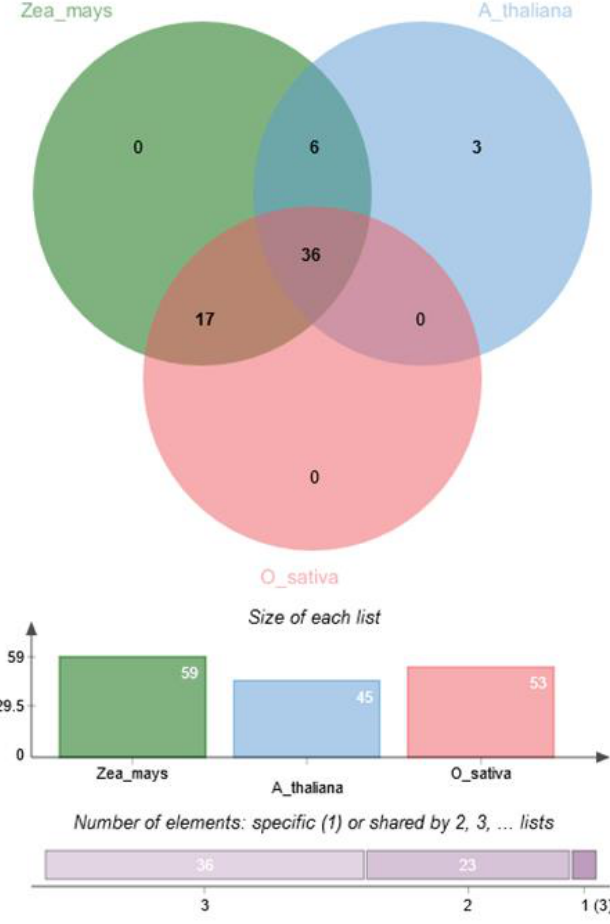
Figure 6. Venn diagram showing the co-expression clusters and overlaps between maize (Zea_mays) and their rice (O_sativa) and Arabidopsis (A_thaliana) orthologs. Co-expression between maize pre-CG and rice and Arabidopsis thaliana orthologs.